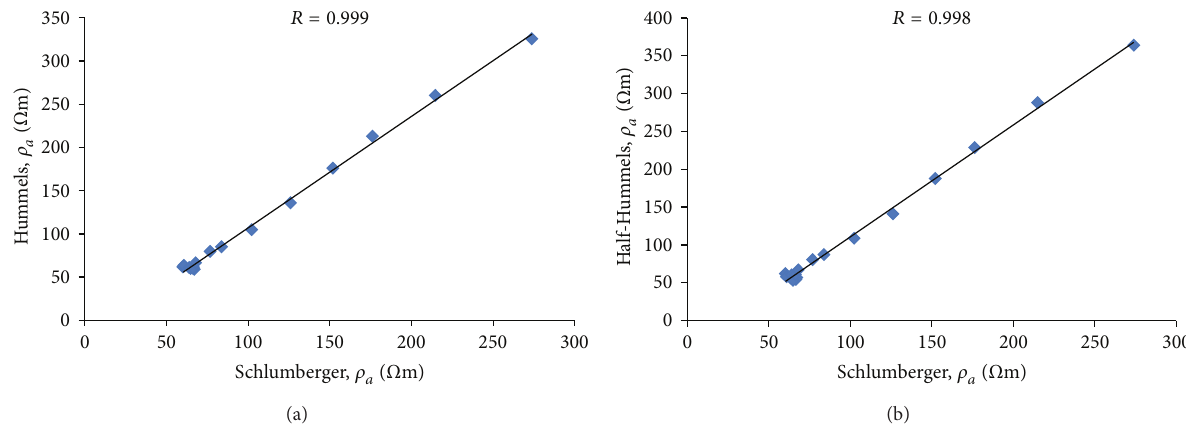
Figure 10: Statistical plot of apparent resistivity data for location 31 (quartz schist) (a) Hummel against conventional Schlumberger (VES) and (b) “Half-Hummel” against conventional Schlumberger (VES).